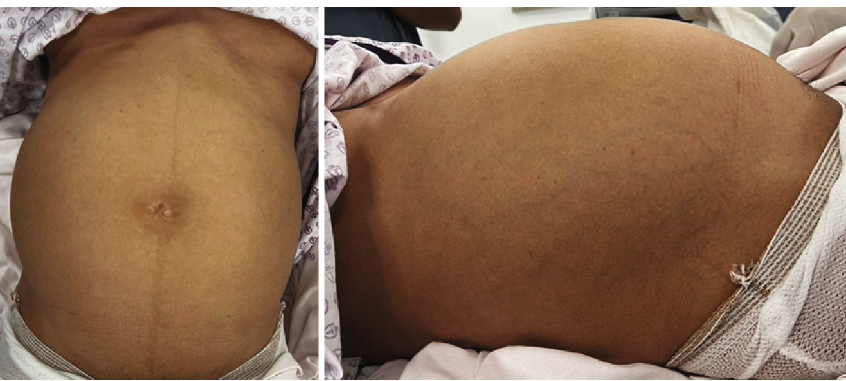
Figure 1: Abdominal inspection showing di ff use abdominal distension.